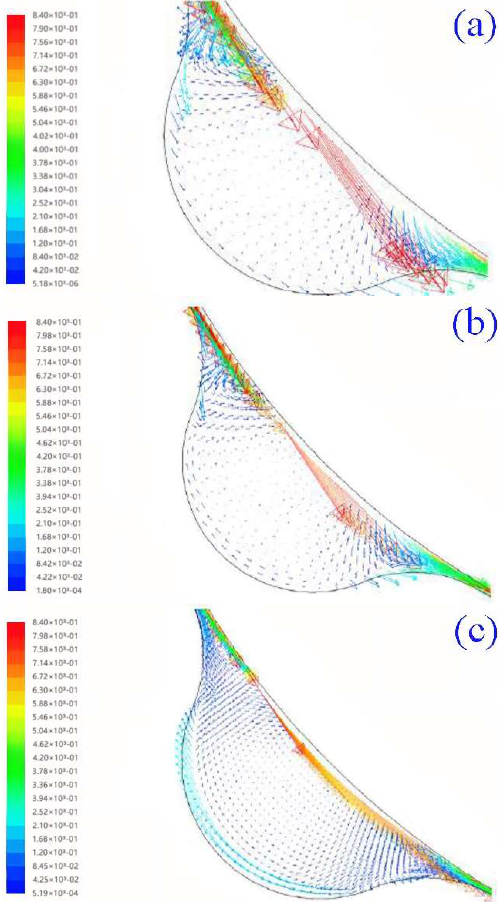
Figure 8. 0.07 MPa oil output speed distribution ( a ); 0.08 MPa oil output speed distribution ( b ); 0.09 MPa oil output speed distribution ( c ).